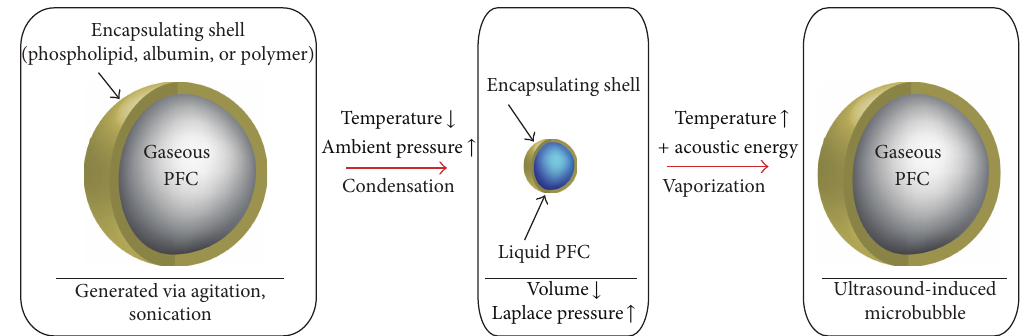
Figure 3: Exposing preformed PFC microbubbles to decreased ambient temperature and increased ambient pressure results in condensation of the gaseous core. The decreased size results in an increased Laplace pressure, which serves to preserve the particle in the liquid state. Once exposed to increased temperature and energy delivered via ultrasound, vaporization of the droplet core results in a larger, highly echogenic gas microbubble. Reprinted from [77], Copyright 2012, with permission from